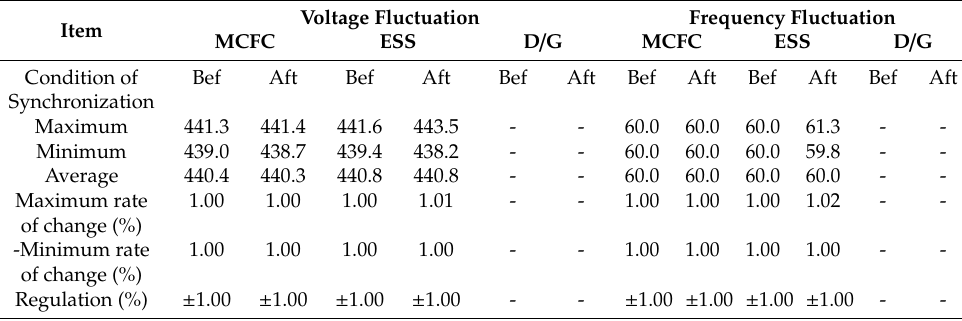
Table 16. Power data analysis before and after ESS system outage.